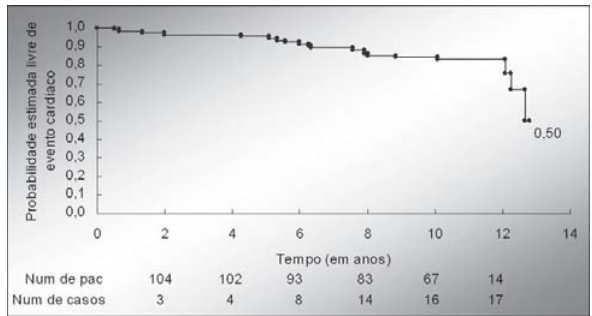
Fig. 4 – Probabilidade estimada livre de evento cardíaco